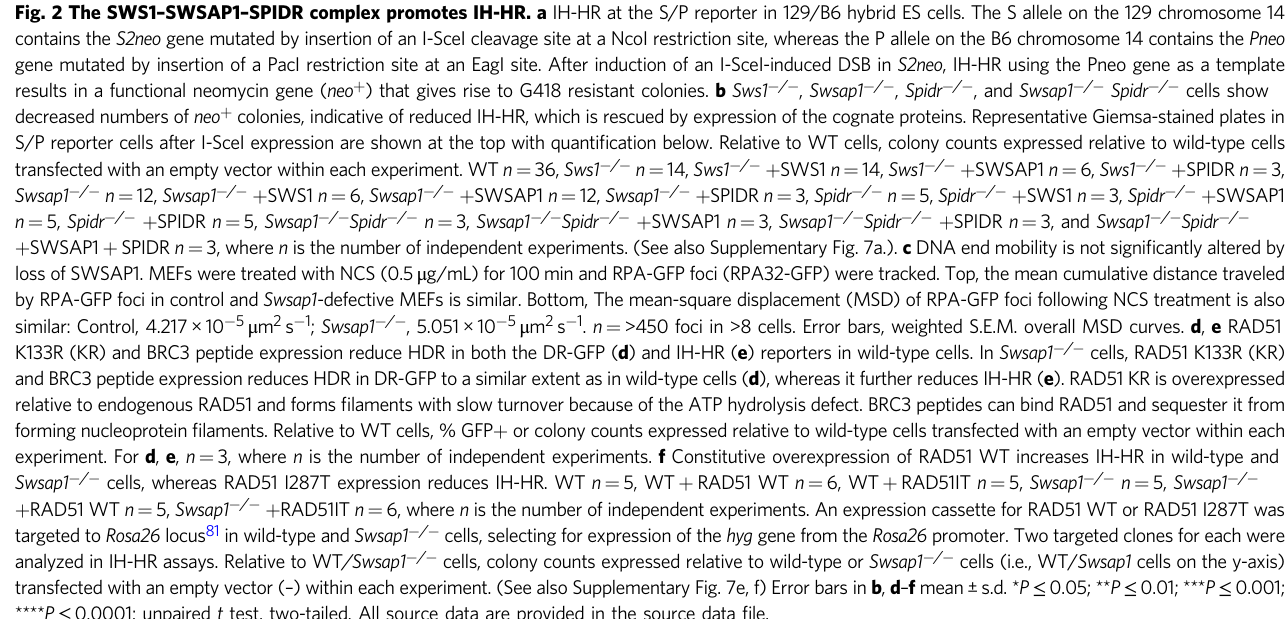
and BRC3 peptide expression reduces HDR in DR-GFP to a similar extent as in wild-type cells ( d ), whereas it further reduces IH-HR ( e ). RAD51 KR is overexpressed relative to endogenous RAD51 and forms fi laments with slow turnover because of the ATP hydrolysis defect. BRC3 peptides can bind RAD51 and sequester it from forming nucleoprotein fi laments. Relative to WT cells, % GFP + or colony counts expressed relative to wild-type cells transfected with an empty vector within each experiment. For d , e , n = 3, where n is the number of independent experiments. f Constitutive overexpression of RAD51 WT increases IH-HR in wild-type and Swsap1 − / − cells, whereas RAD51 I287T expression reduces IH-HR. WT n = 5, WT + RAD51 WT n = 6, WT + RAD51IT n = 5, Swsap1 − / − n = 5, Swsap1 − / − + targeted to Rosa26 locus 81 in wild-type and Swsap1 − / − cells, selecting for expression of the hyg gene from the Rosa26 promoter. Two targeted clones for each were transfected with an empty vector ( – ) within each experiment. (See also Supplementary Fig. 7e, f) Error bars in b , d – f mean±s.d. * P ≤ 0.05; ** P ≤ 0.01; *** P ≤